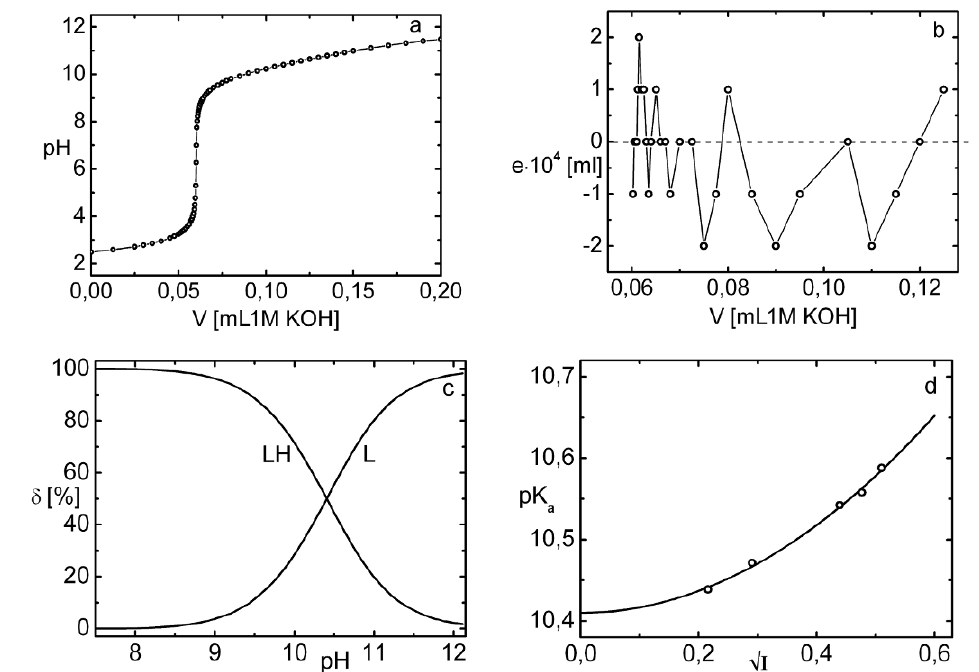
Figure 2. Protonation equilibria of naphazoline acid analyzed with ESAB (a) Potentiometric titration curve of naphazoline acid with KOH; L = 4.992·10 -3 mol dm -3 , H = 0.8961 mol dm -3 , V = 15.05 cm 3 , I = 0.0008 [mol dm -3 ], T = 25°C; (b) Scatterplot of residuals; 0 T 0 (c) Distribution diagram of relative amounts of all variously pronated species in the protonation equilibrium, (d) Dependence of the mixed dissociation constant p K of naphazoline acid on the square root of the ionic strength, which leads to parameter estimates a T p K = 10.41(1) at a1